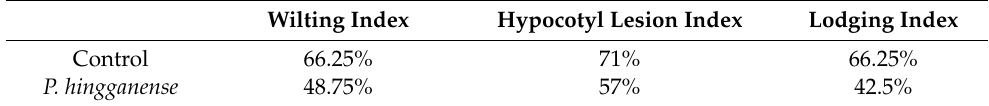
Figure 5. Symbiosis with P. hingganense induces resistance to disease caused by Rhizoctonia solani . ( A ) Dual culture assay showing moderate antagonistic activity of P. hingganense (left) against R. solani (right). ( B ) Phenotype comparison of P. hingganense − treated and non − treated plants on the 7th day after inoculation of R. solani . Values are means ± SD (n = 20). ( C – E ) Comparison of MDA content ( C ), total phenolic content ( D ), and total flavonoid content ( E ). Values are means ± SD (n = 3). Asterisks indicate significant differences as evaluated by Student’s t -tests: * p < 0.05, ** p < 0.01, *** p < 0.001. MDA, malondialdehyde; GAE, gallic acid equivalent; QE, quercetin equivalent. Table 1. Biocontrol efficiency of Parametarhizum hingganense